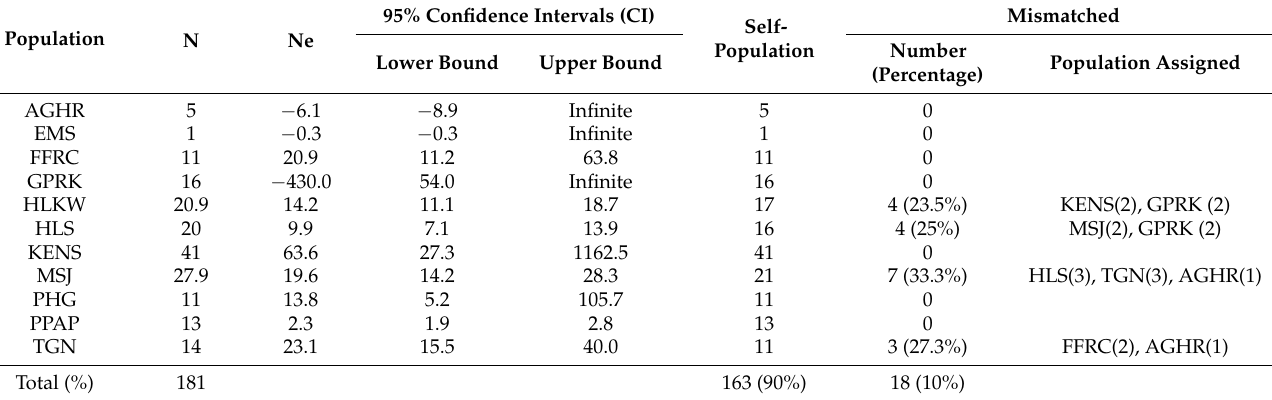
Table 7. Population assignment of Tor spp. and respective estimates of effective population size (Ne) within each population.